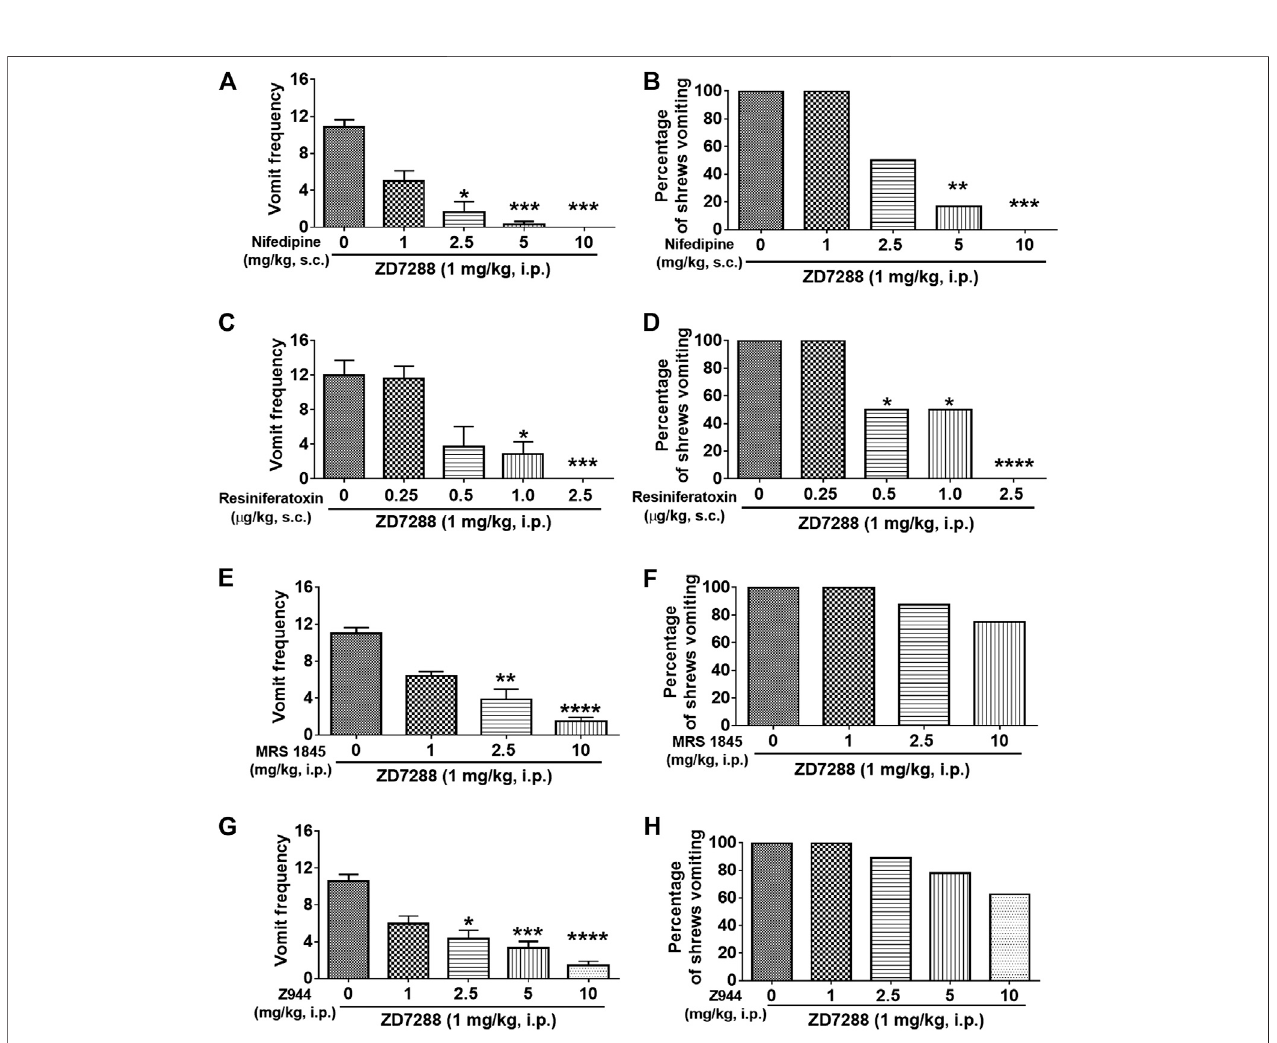
FIGURE 10 | Effects of modulators of cell membrane Ca 2+ channels on the HCN channel blocker ZD7288-induced emesis. Different groups of least shrews were given an injection of either the corresponding vehicle, or varying doses of: 1) The L-type Ca 2+ channel (LTCC) inhibitor nifedipine (s.c.) ( n (cid:2) 6 shews per group); 2) the TRPV1Ragonistresiniferatoxin(RTX)(s.c.)( n (cid:2) 8);3)store-operatedCa 2+ entryblockerMRS1845(i.p.) ( n (cid:2) 8);4)T-typeCa 2+ channelinhibitorZ944(i.p.)( n (cid:2) 9),30 min prior to ZD7288 injection (1 mg/kg, i. p.). Emetic parameters were recorded for the next 30 min (A, C, E, G) The frequency of emesis was analyzed with Kruskal- Wallis non-parametric one-way ANOVA followed by Dunnett ’ s post hoc test and presented as mean ± SEM. (B, D, F, H) Percentage of shrews vomiting was analyzed with chi-square test and presented as mean. * p < 0.05, ** p < 0.01, *** p < 0.001, **** p < 0.0001 vs. 0 mg/kg.